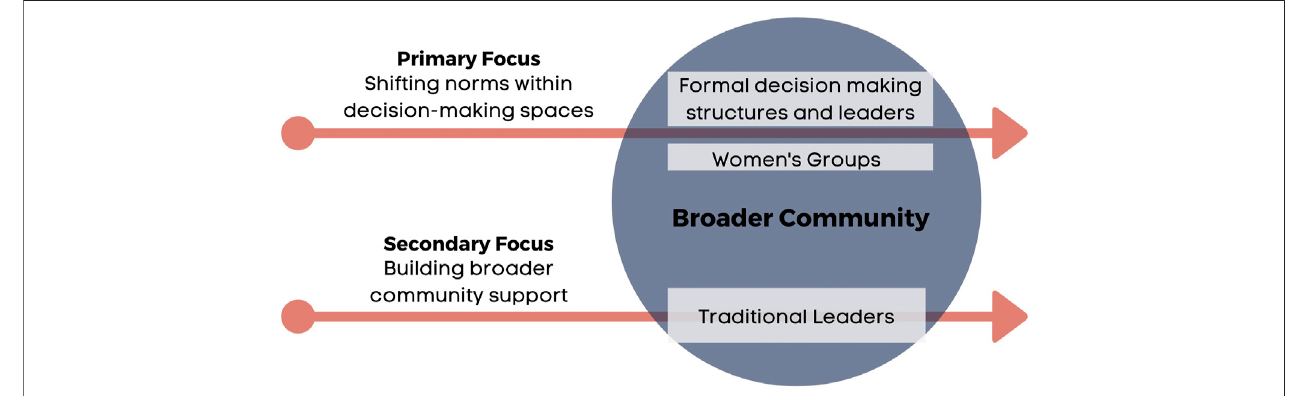
FIGURE 1 | UPWARD intervention focus and target